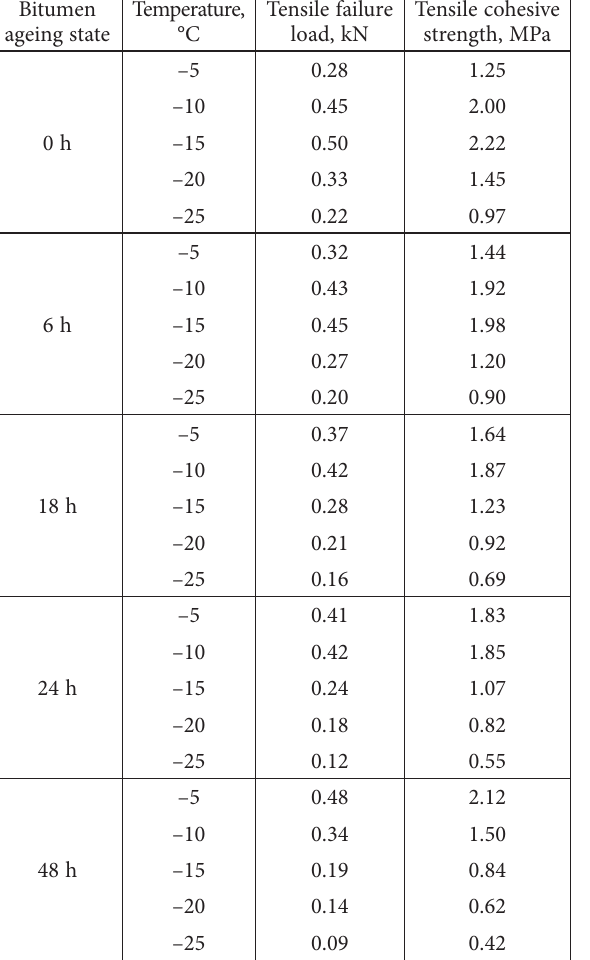
Table 3. Test results of the low-temperature cohesive strength of the PE-modified bitumen at different ageing states Bitumen Temperature, Tensile failure Tensile cohesive ageing state °C load, kN strength, MPa